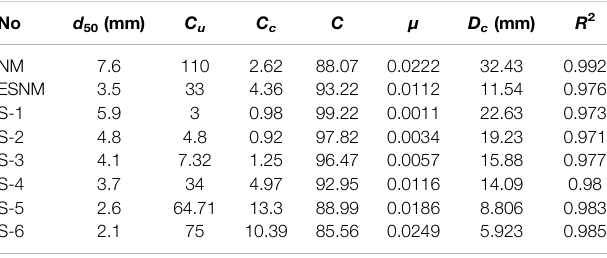
TABLE 1 | Particle size parameters of the natural and experimental